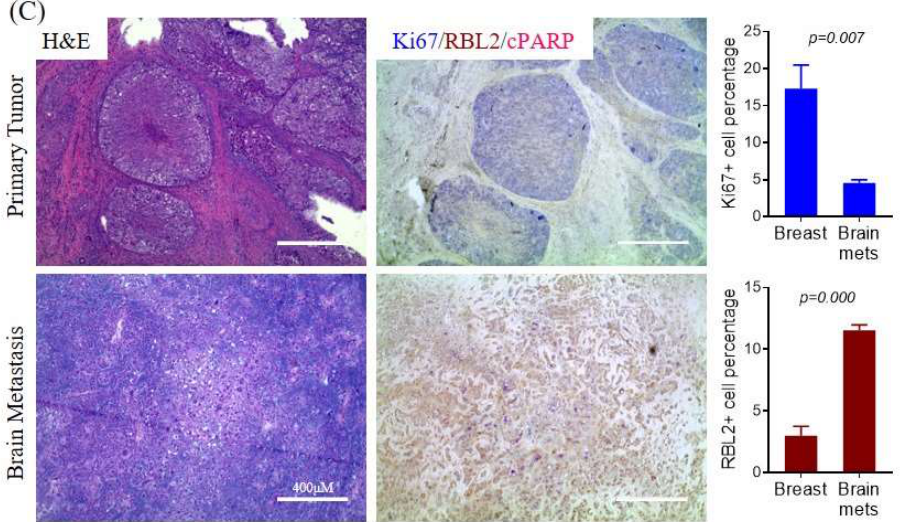
Figure 6. IHC analyses of mTORC2 activity in BC patient samples. Paired primary and metastatic patient BC samples show differences in proliferation and mTORC status. ( A ) Flowchart for IHC evaluation of tumor (left) and images of representative BC brain metastasis serial sections (right) stained for H&E; GCDFP-15+MG (blue) confirming mammary origin of tissue; Ki67/RBL2/cleaved PARP-Asp214 (cPARP), Ki67 (blue, proliferation marker), RBL2 (brown, quiescence marker) [34], cPARP (red, apoptosis marker); and pNDRG1 (brown, mTORC2 status marker), p70S6K (red, mTORC1 status marker) (scale bar = 100 μm). Yellow arrows indicate quiescent cells (RBL2+ and pNDRG1− cells). ( B ) Serial section IHC images of primary and paired brain metastasis for H&E